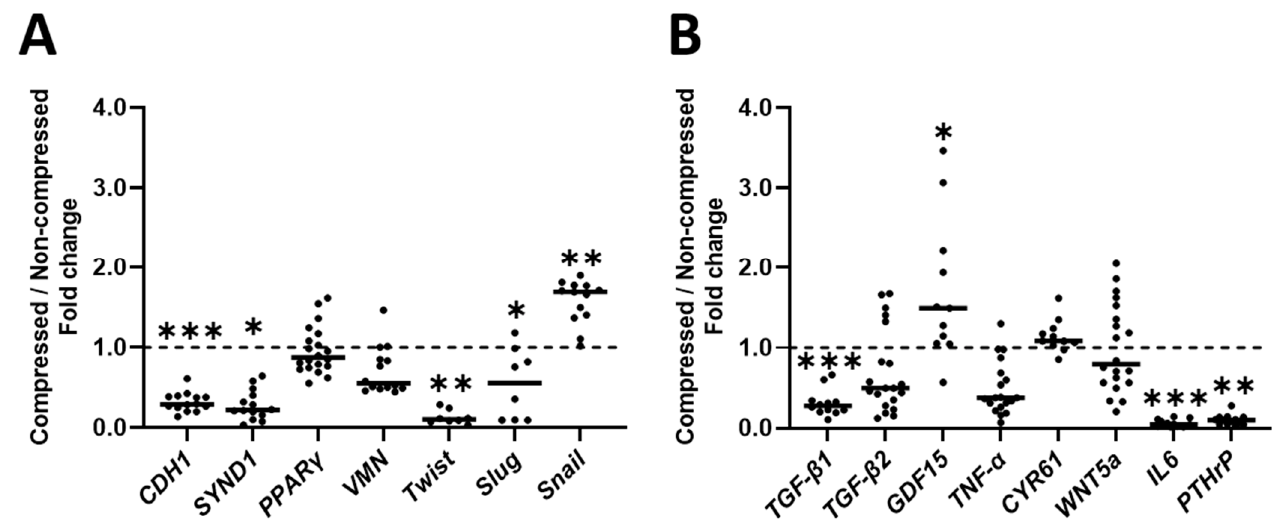
Figure 2. Effect of compression on gene expression related to EMT in DU145 cells . 20 separate DU145 cell cultures were compressed with 2 kPa for 2 days, followed by qPCR on ( A ) Gene expression of EMT-related factors expressed in- or on PC cells ( n = 8–20), and ( B ) Gene expression of EMT-related signaling molecules ( n = 11–20). VMN , WNT5a and PPAR γ were analyzed with paired t -tests. Slug , GDF15 and TGF- β 1 were analyzed with normal t -tests. CDH1 was analyzed with a paired t -test on log-transformed data. Snail was analyzed with a normal t -test on log-transformed data. CYR61 , Twist , PTHrP , IL6 and SYND1 were analyzed with Mann–Whitney U tests. TGF- β 2 was analyzed with a Wilcoxon signed-rank test.* p < 0.05, ** p < 0.01, *** p < 0.001.